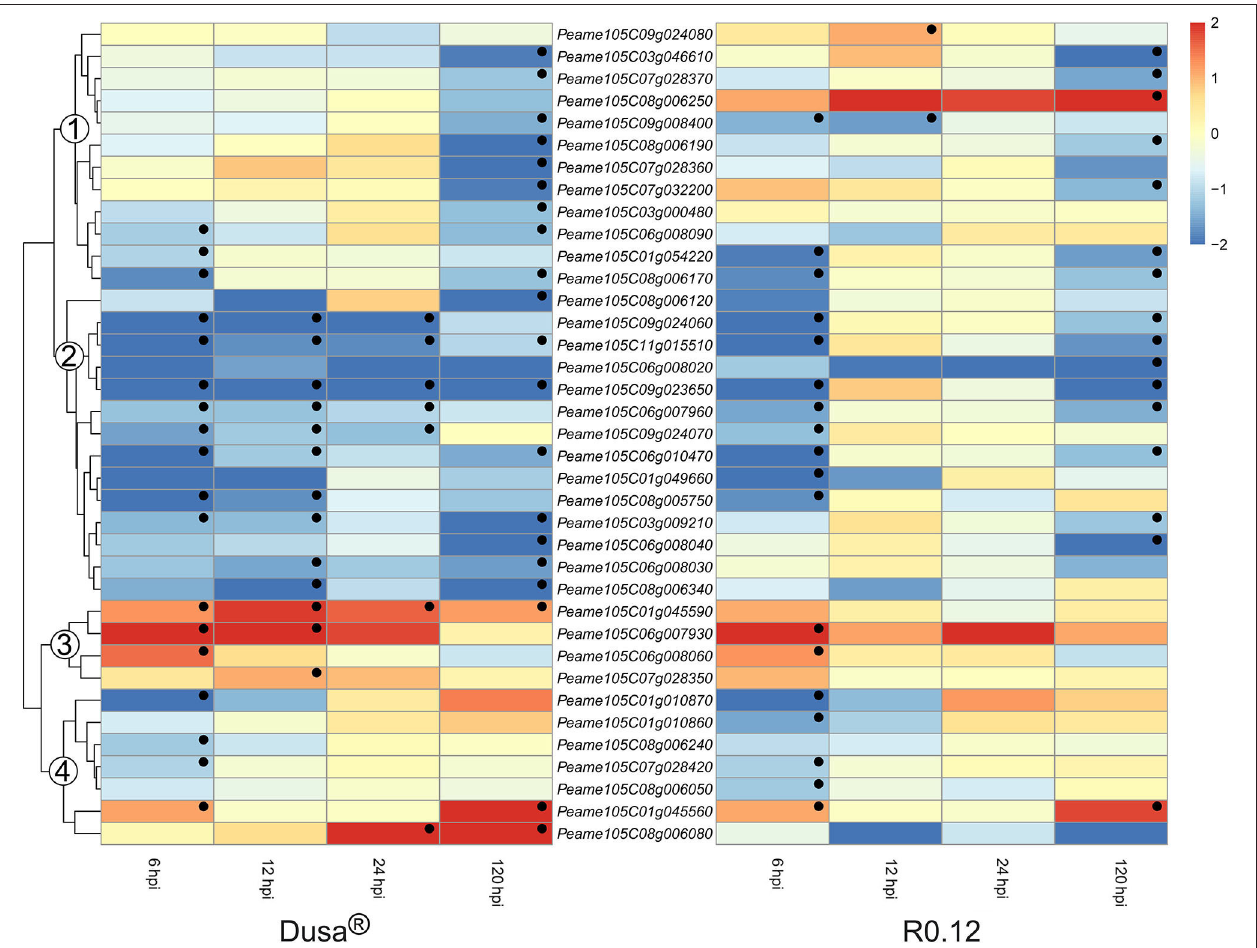
FIGURE 11 | Heatmap and dendrogram illustrating the expression of genes encoding for apoplastic subtilases (SBTs) in Persea americana following inoculation with Phytophthora cinnamomi. Differentially expressed genes (DEGs) encoding for apoplastic SBTs from both partially resistant (Dusa ® ) and susceptible (R0.12) P. americana rootstocks are indicated. Differential expression at 6, 12, 24, and 120h post inoculation (hpi), following inoculation with P. cinnamomi , was calculated using mock-inoculated (dH 2 O) sample libraries as the control. Significantly upregulated [log 2 (fold change) > 1, p = 0.05] genes are indicated by a red color, while significantly downregulated [log 2 (fold change) < − 1, p = 0.05] genes are indicated in blue, the intensity of which represents scale. Significant DEGs are indicated with a black dot. The expression of SBT coding genes were broadly clustered into four groups based on the dendrogram from Dusa ® and were indicated numerically on the dendrogram. Only SBTs that were differentially expressed in one or more samples and were predicted to localize to the cell membrane or extracellular space are